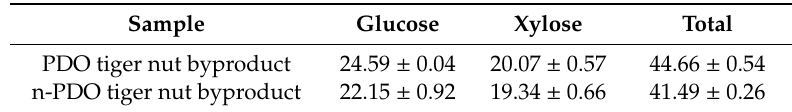
Table 9. Sugars content in the hydrolyzed tiger nut byproducts (g / 100 g of tiger nut byproduct